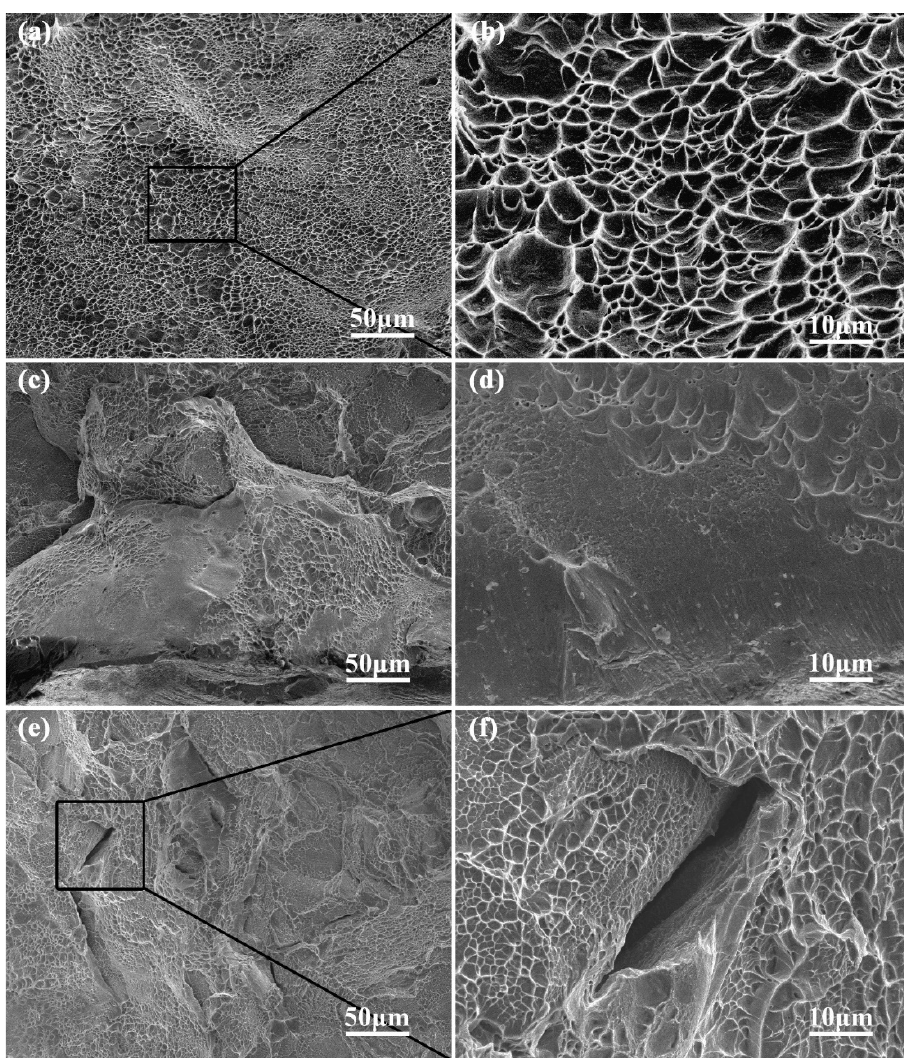
Figure 15. The SEM images of fracture surfaces of SLM processed Ti-55511: ( a , b ) horizontal sample X and ( c – f ) vertical sample Z at room temperature. and ( c – f ) vertical sample Z at room